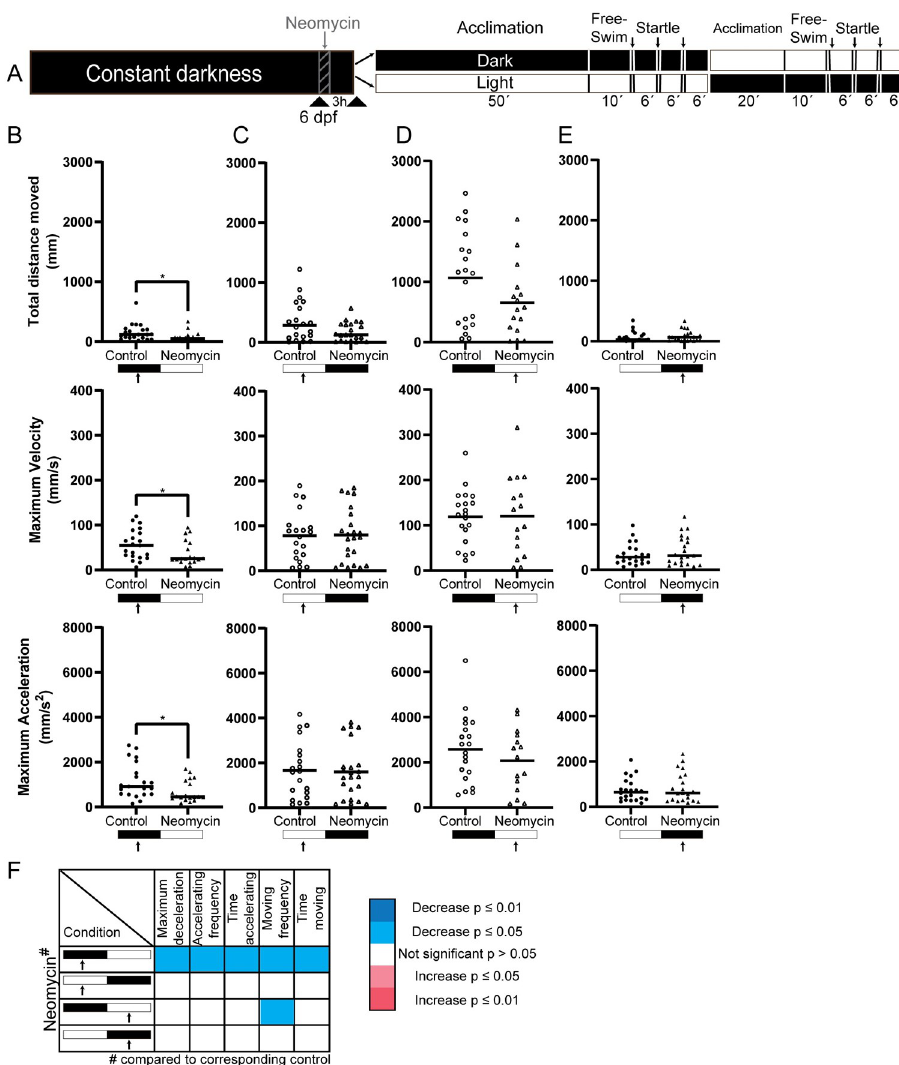
Fig 3. Neuromast ablated larvae exhibited free-swimming phenotype under dark condition. (A) Schematic of the experimental procedure. After 1 h of neomycin treatment embryos were kept in fresh embryo medium for 3 h to recover. Each behavioral section had two components; free-swimming for 10 min under light (open circles/triangles; white) or dark (solid circles/triangles; black) conditions after a 50 min acclimation period under same illumination condition, and a set of startle responses (280 ms) where a sequence of three taps was executed with 6-minute interval; arrows designate timing of taps. For the sequential illumination test, larvae were given a 20-min acclimation period prior to assessing behavior under the illumination condition opposite to initial one. (B) Neomycin treated larvae (triangles) had significantly less locomotor activity under initial darkness. (C, D) However, under light conditions both control and neomycin treated larvae can reach comparable maximum velocity and maximum acceleration regardless of order of light condition. (E) Larvae tested under dark condition followed by light did not show free-swim phenotype after neomycin treatment. (F) Heatmap representation of other analyzed parameters indicated only under first darkness, neomycin phenotype can be detected. n = 15–23 per group. Data is presented in scatterplots showing individual values and group mean or median. Significance: � p � 0.05, �� p � 0.01, ��� p � 0.001, ���� p �